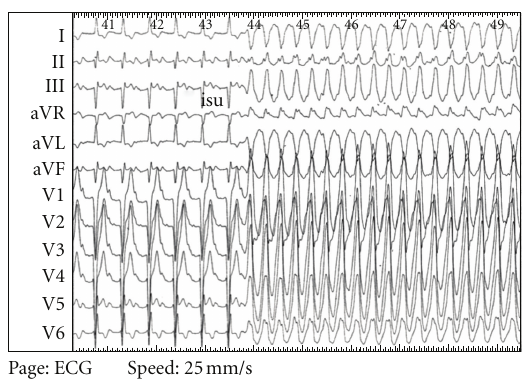
Figure 2: Twelve leads electrocardiogram during endocavitary exploration showing basal-mitral ventricular tachycardia triggered by